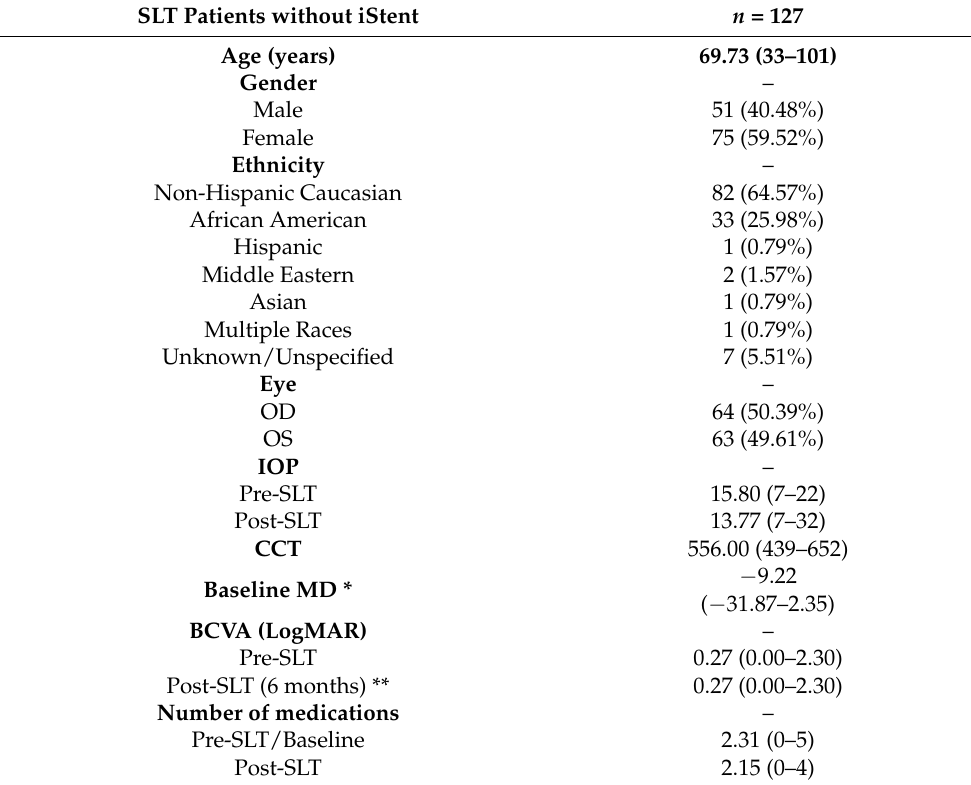
Table 2. Demographic factors of primary SLT patient